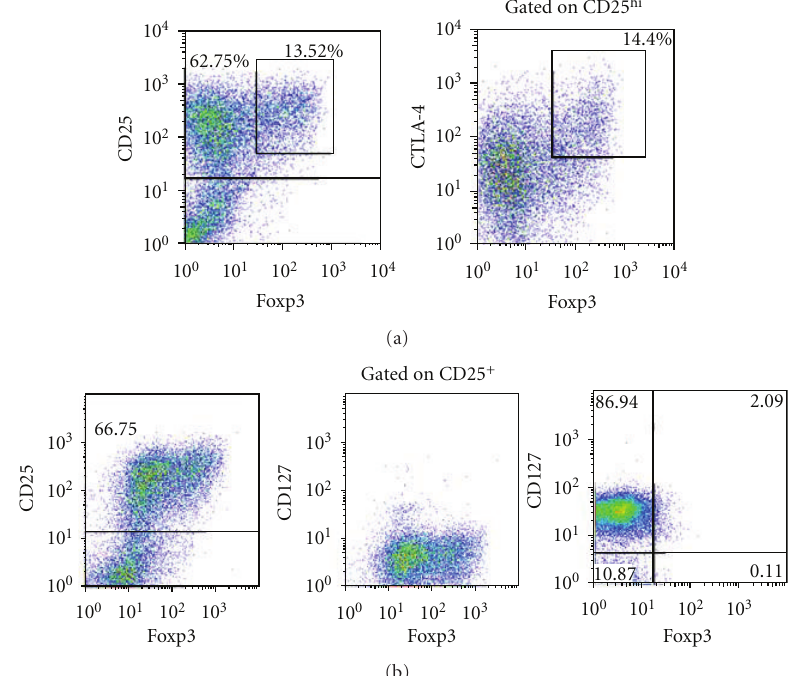
Figure 5: Phenotypic characterisation of putative CD25 hi Foxp3 + Treg cells from cocultures of DC and na¨ıve T cells. The CD25 hi Foxp3 + population expresses CTLA-4 (a) but lacks expression of CD127 in comparison with control Foxp3 − T cells (b), consistent with the reported phenotype of bona fide Treg